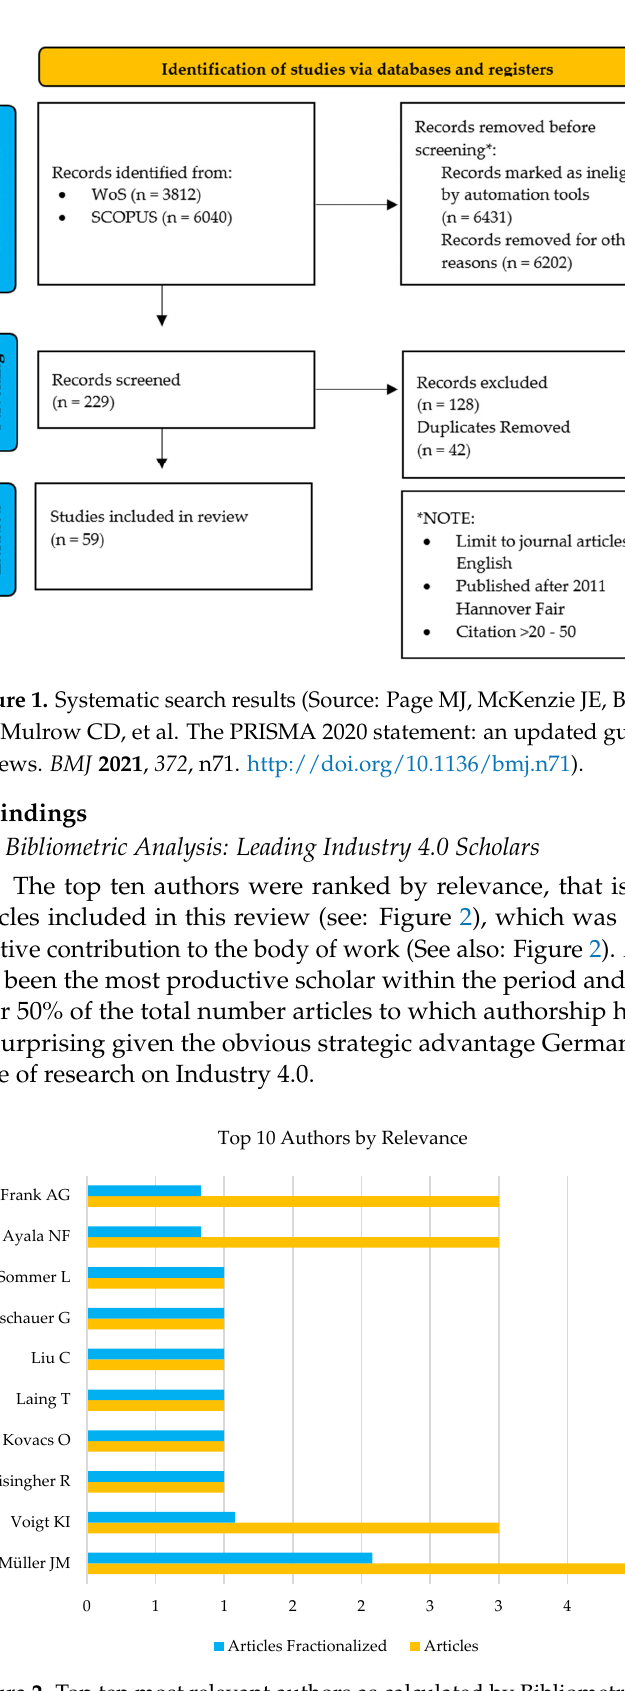
Figure 2. Top ten most relevant authors as calculated by Bibliometrix.